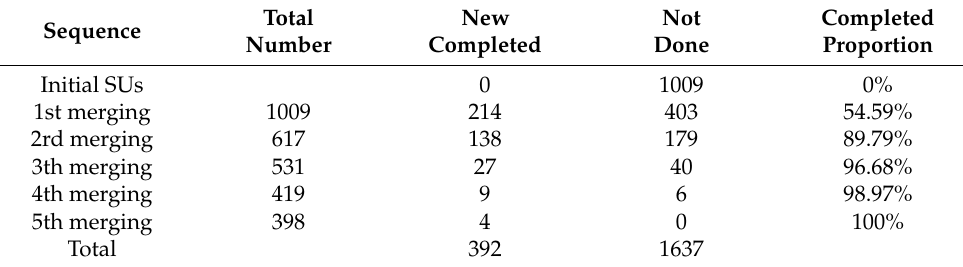
Table 4. Statistical table of artificial merging process from OSSUs to MSSUs.